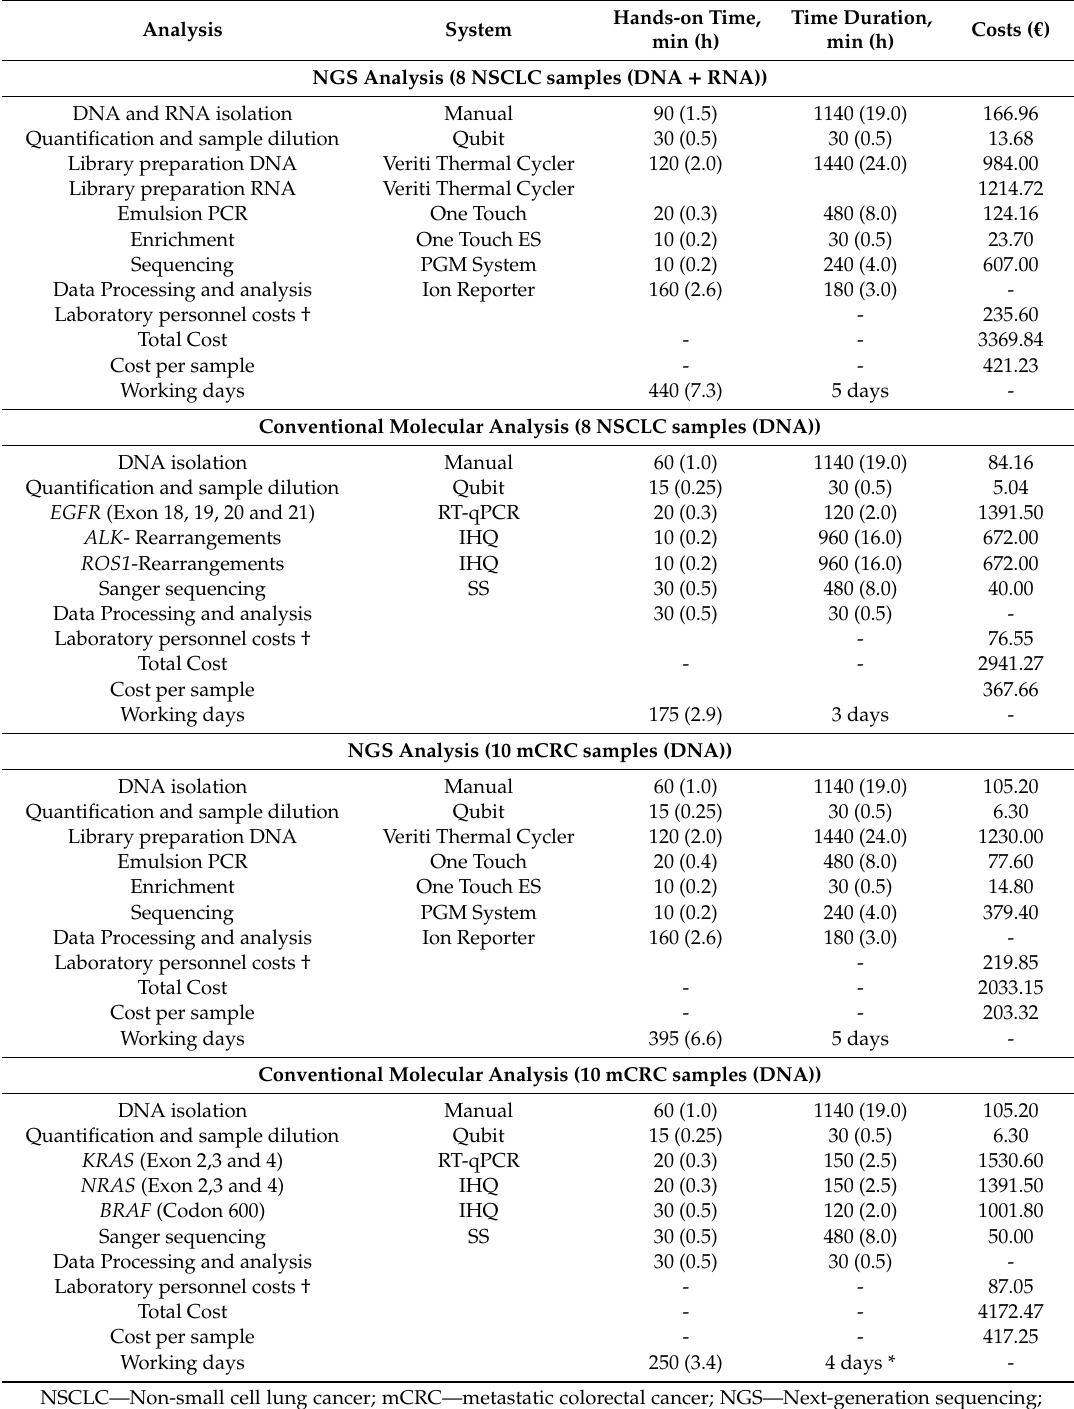
Table 2. Turnaround time and cost comparison between NGS and conventional